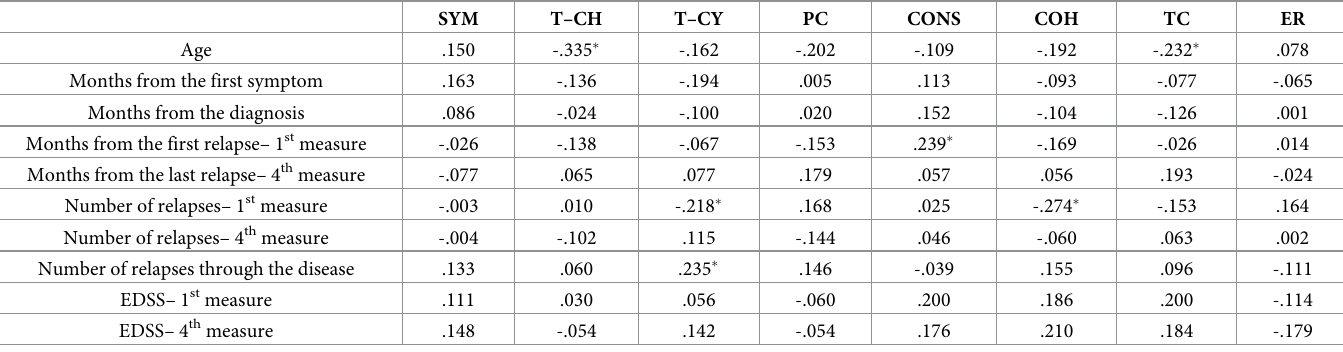
Table 3. Pearson correlation coefficients between IPQ-R subscales, age and medical characteristics of MS. SYM